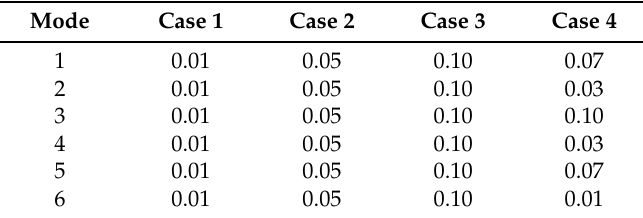
Table 5. Damping ratios for the four cases.